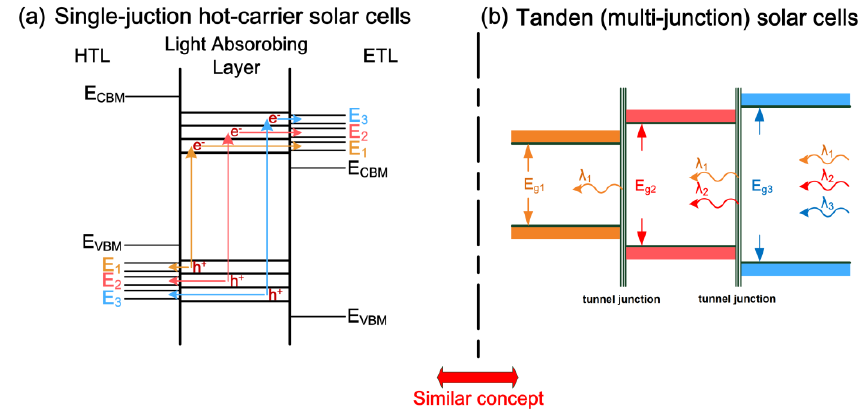
Figure 5. Energy diagrams. ( a ) Single-junction hot-carrier solar cell. ( b ) Tandem solar cell.